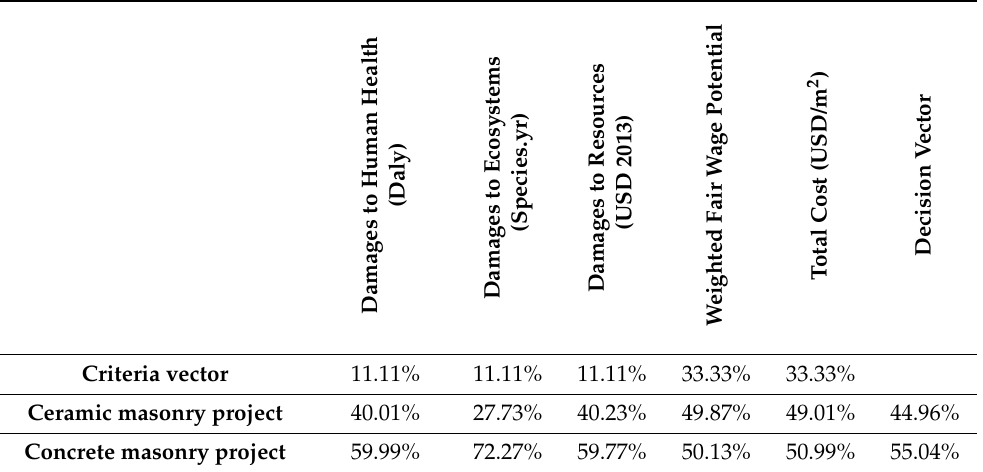
Table 16. Equal weights perspective: sustainability.